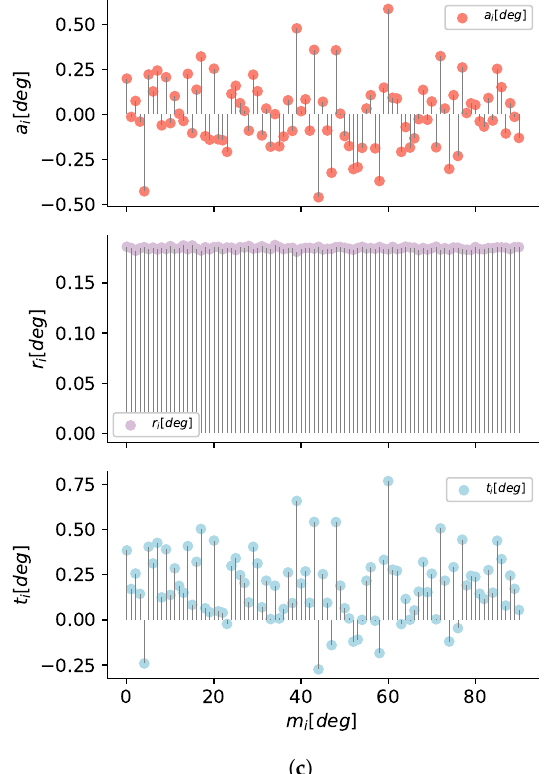
Figure 10. Results of accuracy, repeatability, and total error, for ( a ) x – roll , ( b ) y – pitch , and ( c ) z – yaw , axes of the PCEVDL16I.